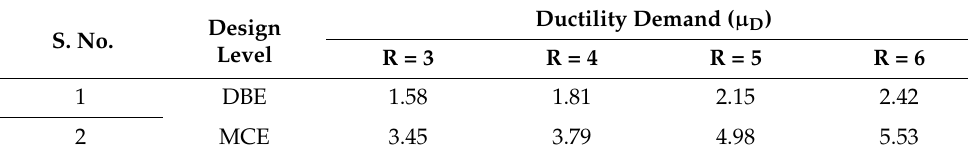
Table 6. Ductility demand at each building case under unidirectional loading. S. No.